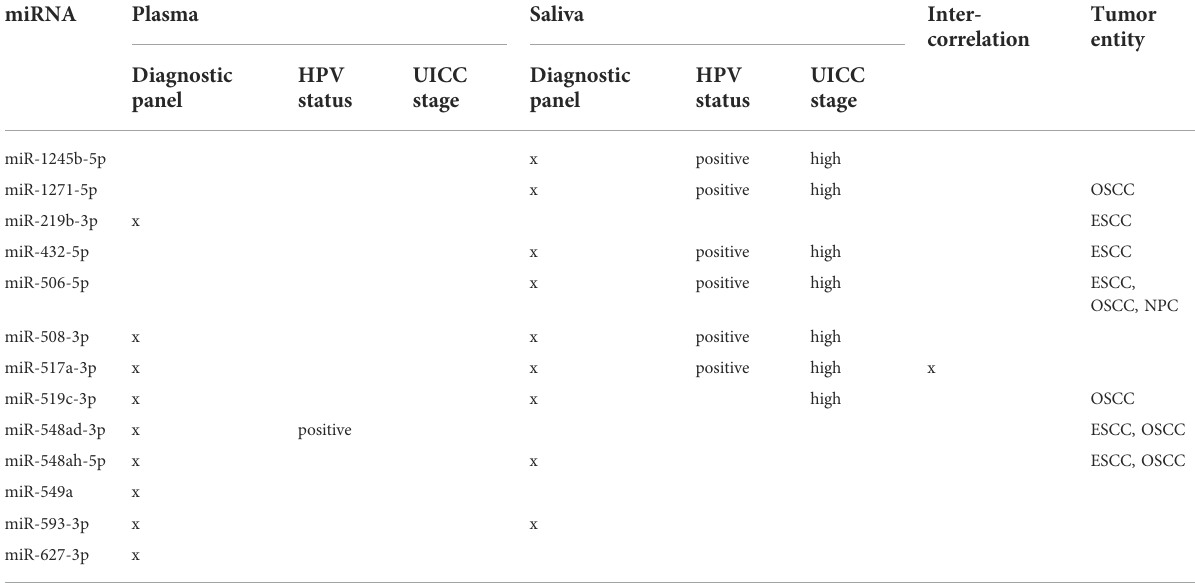
TABLE 1 Combinatorial potential of tumor-exclusive exosomal miRNAs from plasma and saliva.